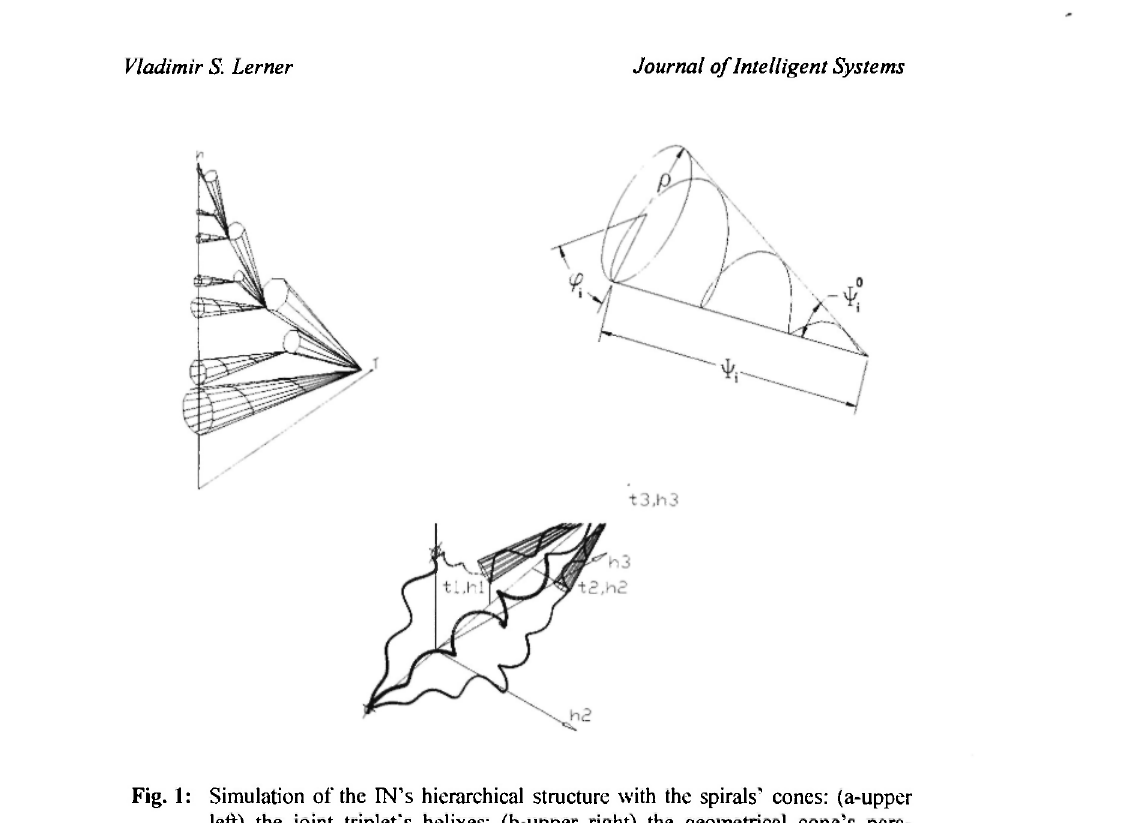
Fig. 1: Simulation of the IN's hierarchical structure with the spirals' cones: (a-upper left) the joint triplet's helixes: (b-upper right) the geometrical cone's para- meters: (c-lower) the origin of fourth dimensional space structure of the triplet's